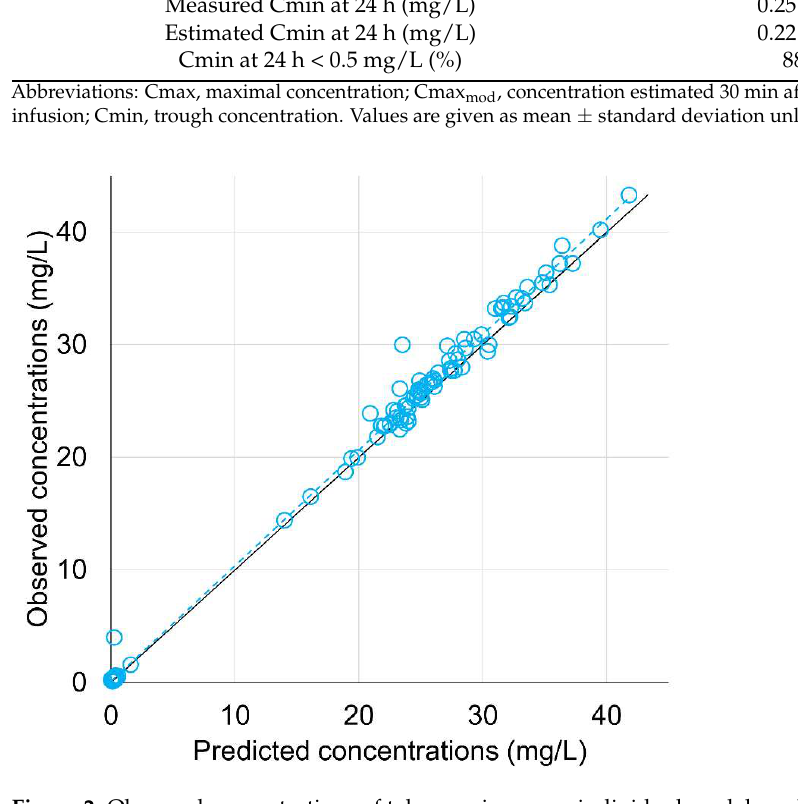
Figure 2. Observed concentrations of tobramycin versus individual model predictions. Blue circles represent observation/prediction pairs. The dashed blue line is the linear regression line. The solid line is the line of identity ( y = x ).